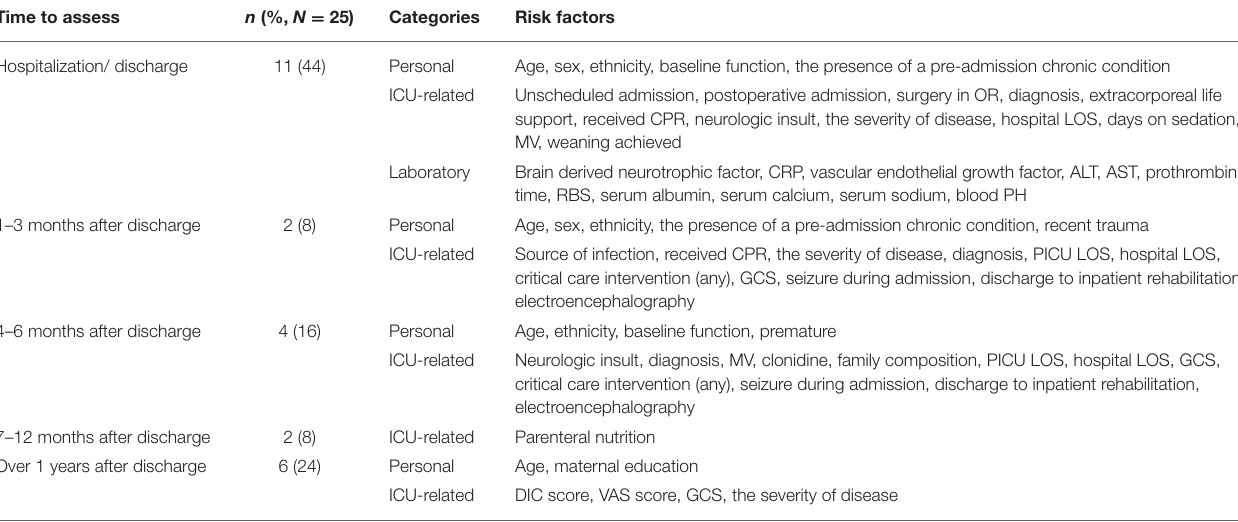
TABLE 2 | Risk factors for physical function